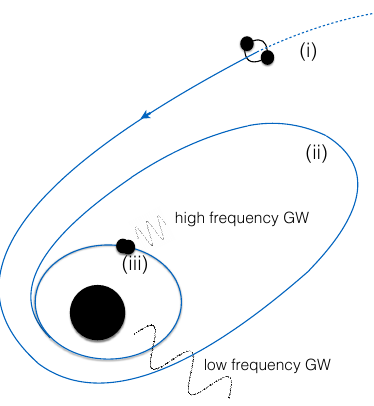
Figure 5. Three evolutionary stages of a binary extreme-mass-ratio inspiral (b-EMRI). First, (i) a compact black hole binary (BHB) is captured to a bound orbit around a supermassive black hole (SMBH) because the pericenter distance becomes comparable to the tidal-disruption radius, R t . Next, (ii) the outer binary circularizes due to gravitational wave (GW) radiation, and the GW frequency lies in the band of a space-borne GW detector. Finally, (iii) the tidal force of the SMBH becomes strong enough to excite the eccentricity of the inner BHB and drive it to merge. The merger produces high-frequency GWs.